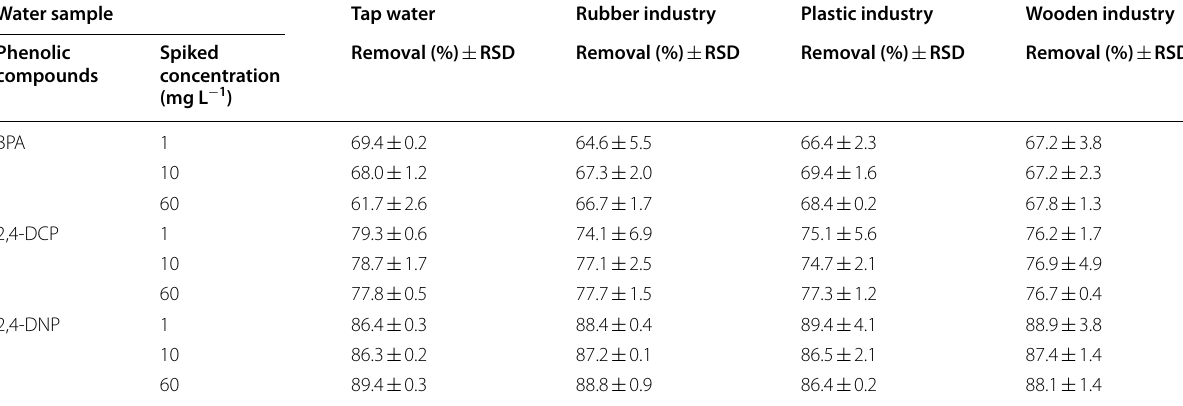
3) of real sample for the removal of phenols by Fe =